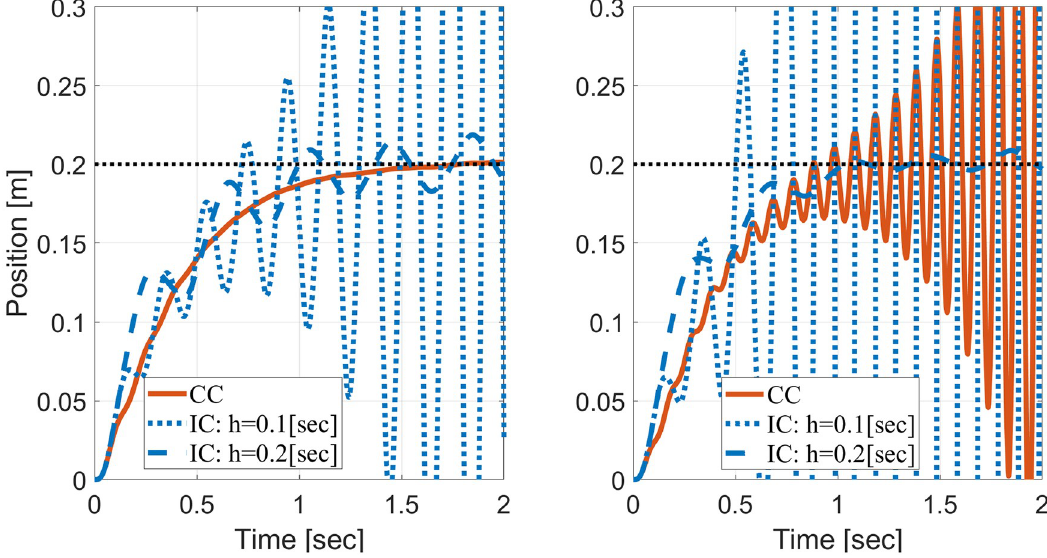
Fig 3. Simulations of reaching movements to demonstrate the stability analysis of Fig 2 for m panel: nominal measurement noise with covariance matrix V = V 0 . Right panel: less noisy measurements with V = V 0